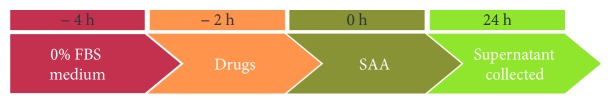
Timeline protocol.